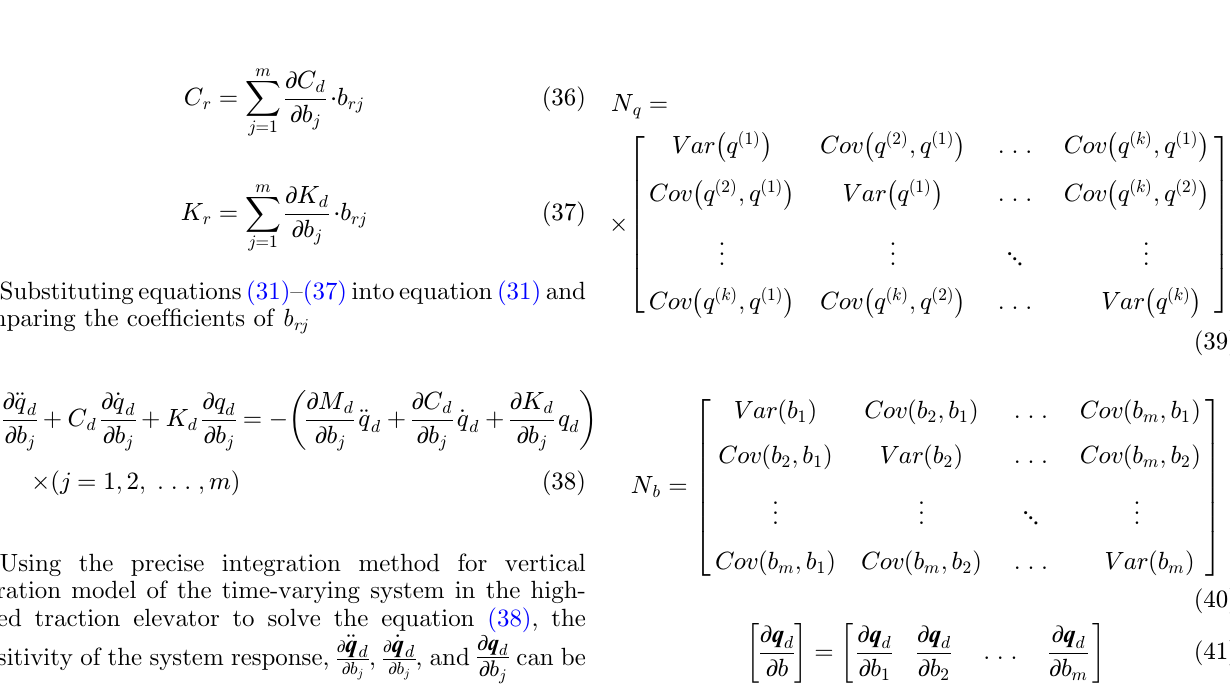
where Var ( q ( k ) ) represents the variance of the k th element in the vector q , and Cov represents the covariance.